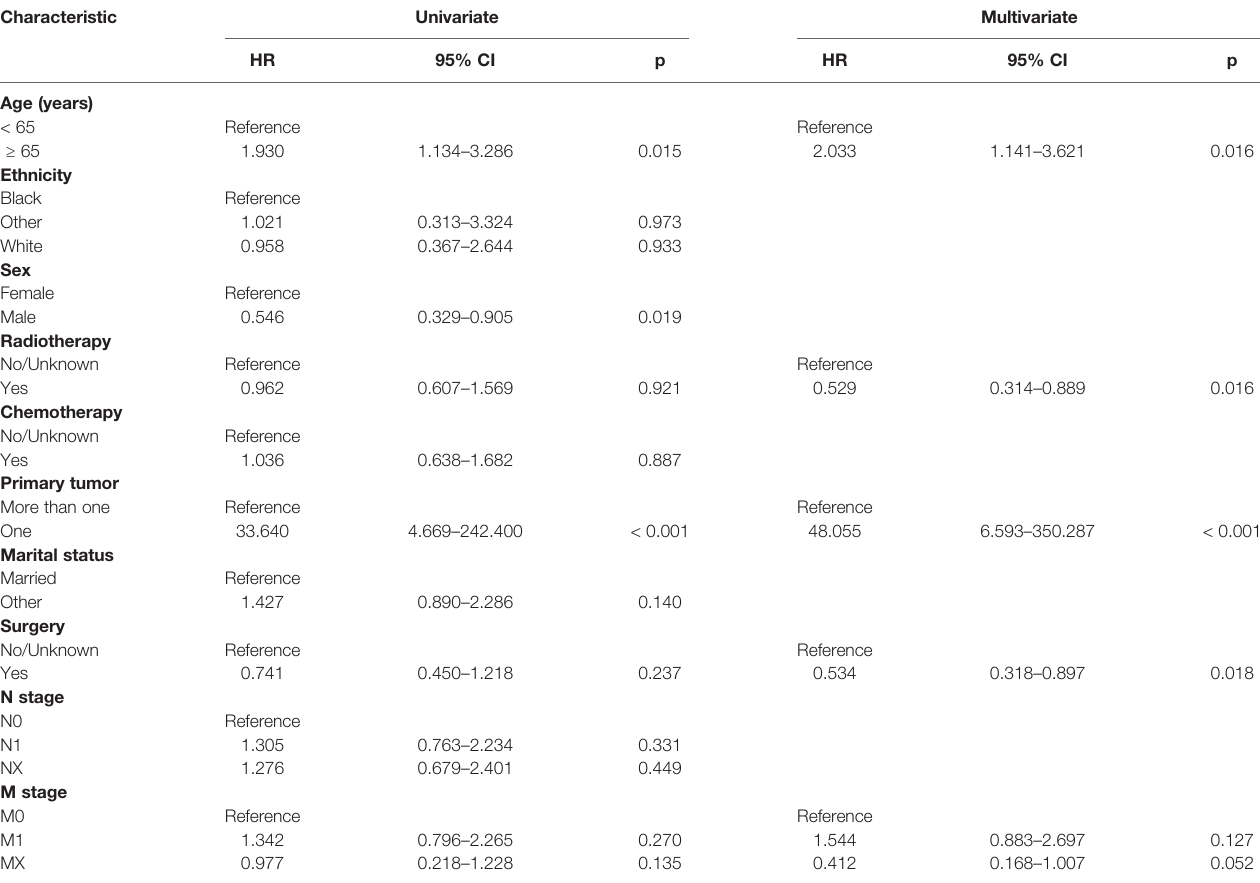
TABLE 3 | Univariate and multivariate Cox regression model of factors associated with CSS in patients with PSCCTh.